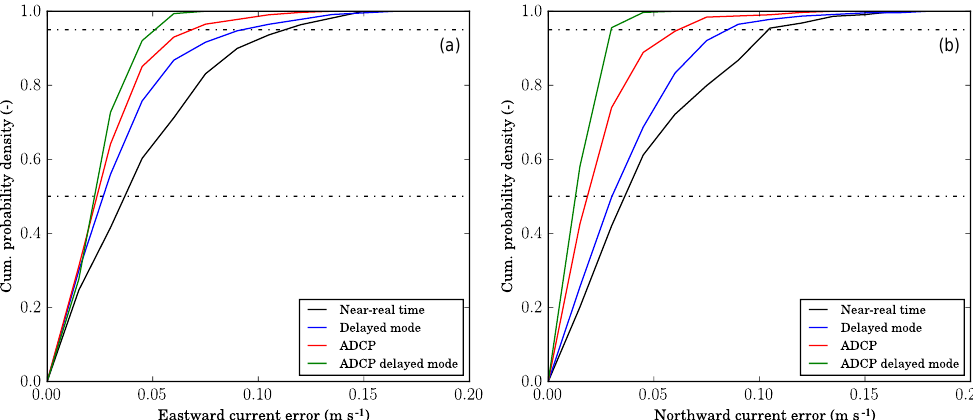
Figure 7. Probability density function estimates of the errors for the eastward current component (left panel) and the northward component (right panel). The black and red curves are derived from the results of the Kalman filter run in near-real-time mode for the glider data and ADCP data, respectively. The blue and green curves are derived from the Kalman filter modified for delayed mode (post-processing); see Sect.